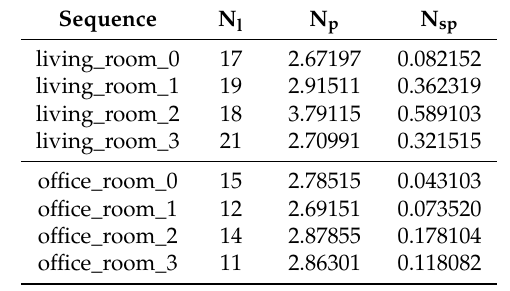
Table 2. The number of plane landmarks and the average number of observed planes on ICL-NUIM dataset. N l denotes the number of plane landmarks. N p denotes the average number of observed planes for every frame. The parameter N sp denotes the average number of supposed planes for every frame.